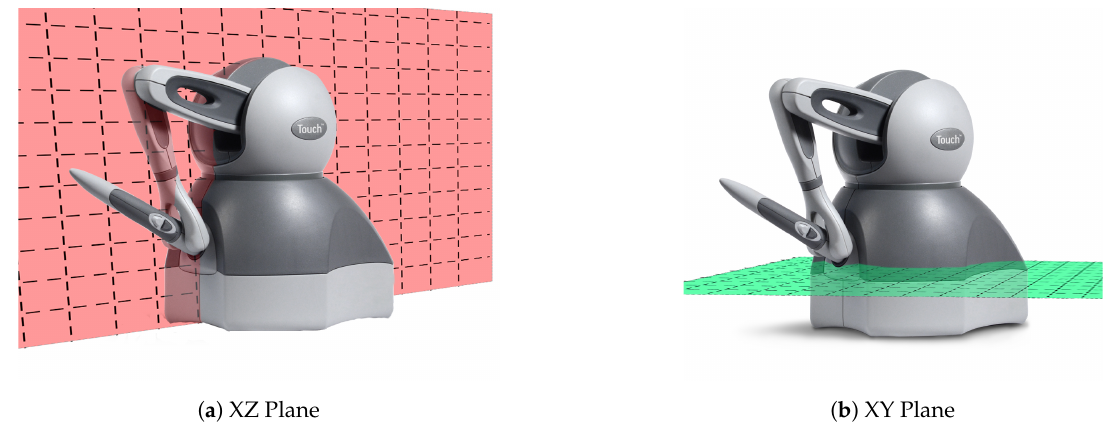
Figure 7. Haptic feedback is rendered as a simple spring force via proxy method to encourage users to stay within a 2D plane, ( a ) for forward and backward, ( b ) for turning. Proxy location is simply user position projected onto rendered